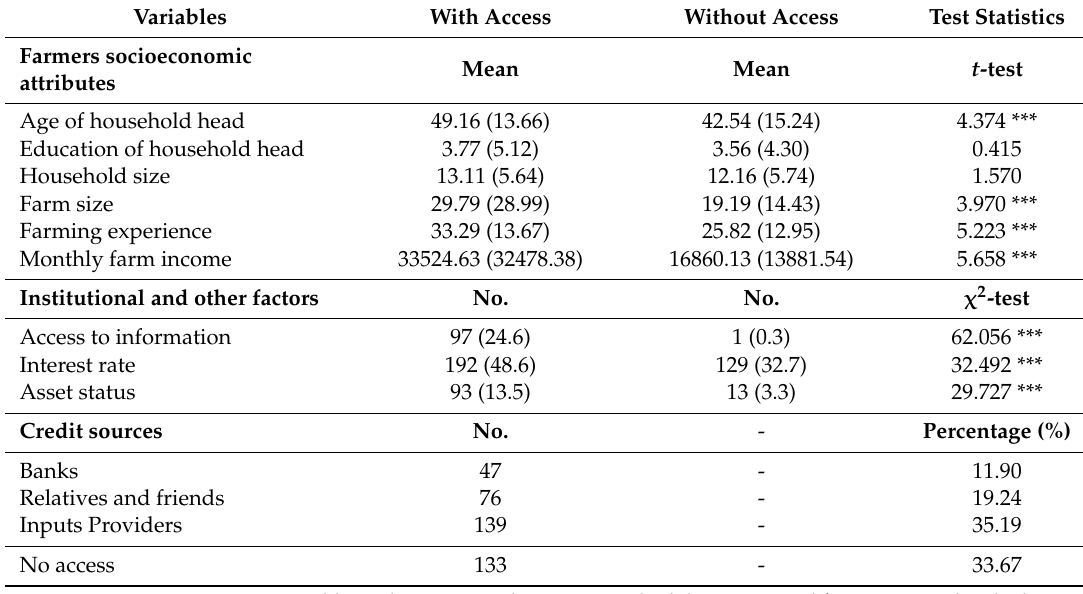
Table 1. Sample overview and summary statistics.